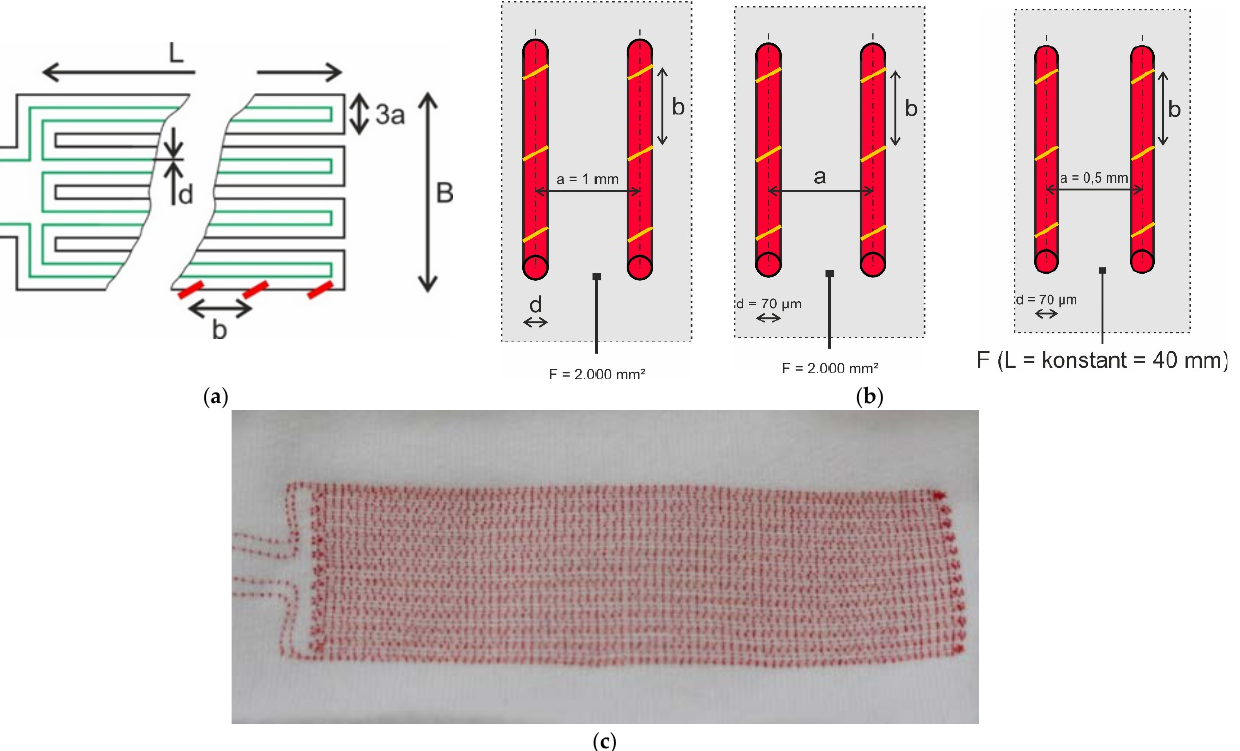
Figure 2. ( a ): Symbolic diagram of the sensor wire array stitched onto the dressing samples. Of the connections on the left (1,2,3,4), 1 and 4 are connections at both ends of the same sensor wire, the same applies to connections 2 and 3. ( b ): Representation of the variables (larger letters) of the series from left to right: Series D (wire diameter d and stitching spacing b); Series S (conductor spacing a and stitching spacing b); Series Fx (sensor width B and stitching spacing b); ( c ): Photo showing an example of the wound dressings used.